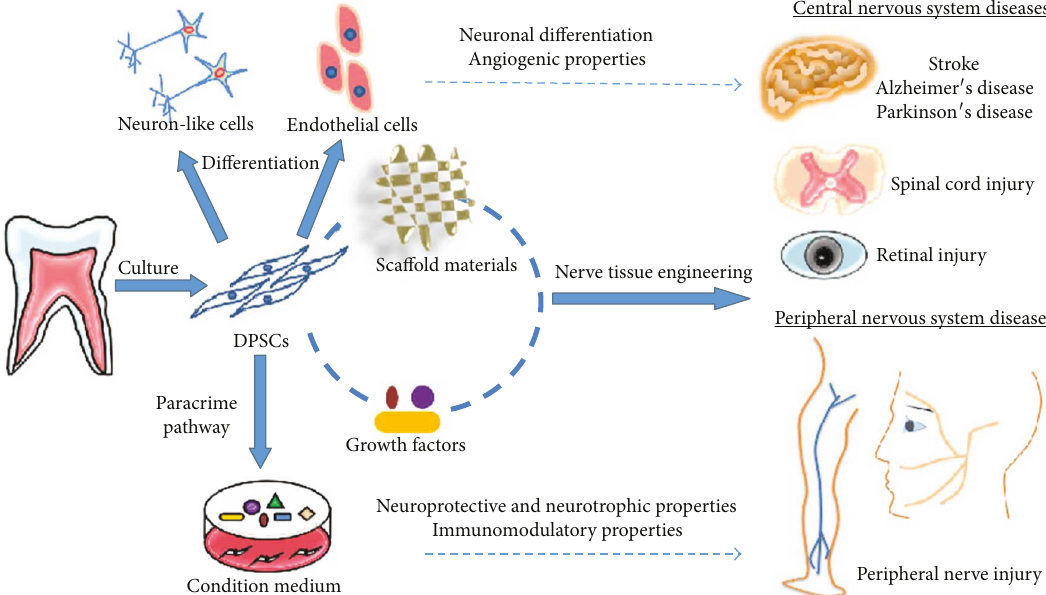
Figure 3: Tissue-engineered constructs of DPSCs, sca ff olds, and growth factors and their applications in nervous system diseases. In the constructs, sca ff olds can provide biomimetic environments and structural support for cell survival and proliferation. Growth factors can promote neuronal cell proliferation and survival in vivo and in vitro . DPSCs can enhance neuronal regeneration and repair due to their neuronal di ff erentiation potential and their neurotrophic, neuroprotective, angiogenic, and immunomodulatory